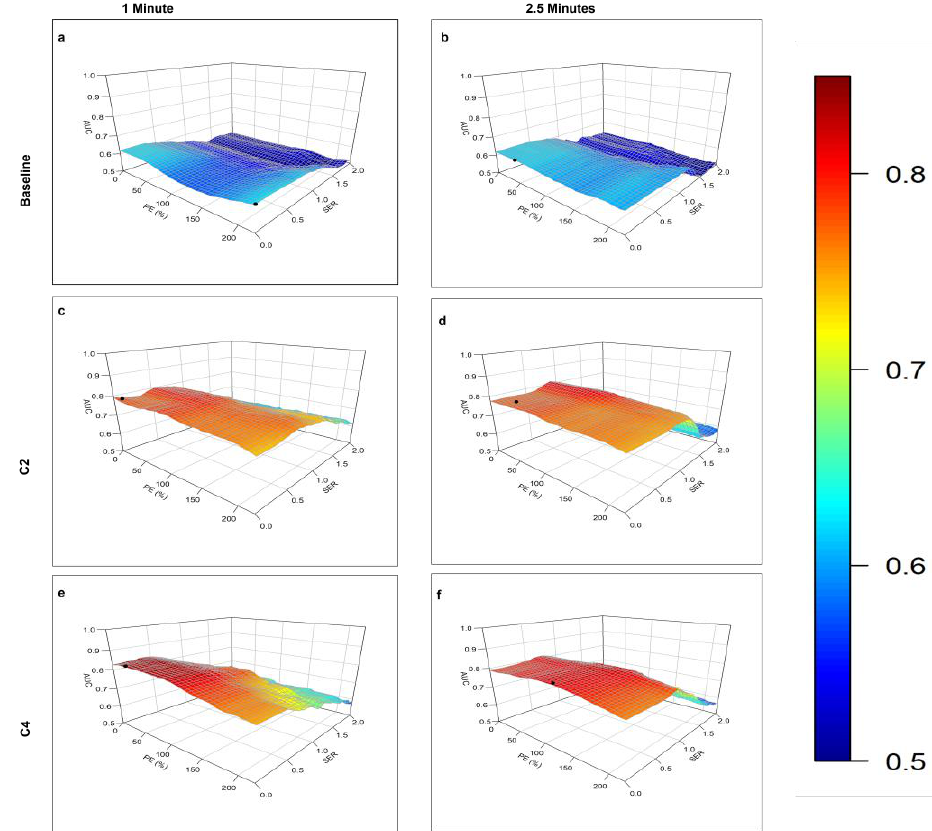
Figure 3. Plots of the area under the receiver operating characteristic curve (AUC) for response prediction as a function of the percentage enhancement (PE) and signal enhancement ratio (SER) used to calculate the functional tumor volume on DCE MRI images obtained ( a , b ) at baseline, 1 min ( a ), and 2.5 min ( b ) after contrast agent injection; ( c , d ) after 2 cycles of neoadjuvant systemic therapy (NAST), at 1 min ( c ), and 2.5 min ( d ) after contrast agent injection; and ( e , f ) after 4 cycles of NAST, at 1 min ( e ), and 2.5 min ( f ) after contrast agent injection. In each case, the PE–SER combination with maximum AUC (black circle) was selected as the optimal